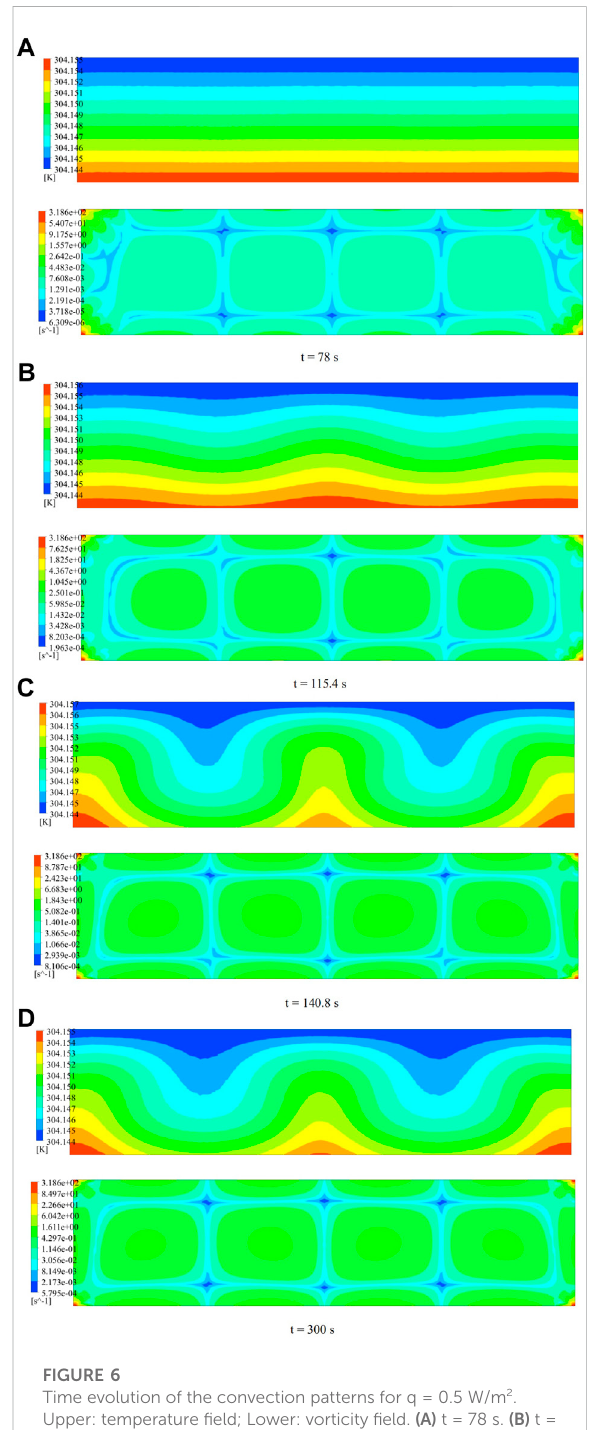
FIGURE 6 Time evolution of the convection patterns for q = 0.5 W/m 2 . Upper: temperature fi eld; Lower: vorticity fi eld. (A) t = 78 s. (B) t = 115.4 s. (C) t = 140.8 s. (D) t = 300